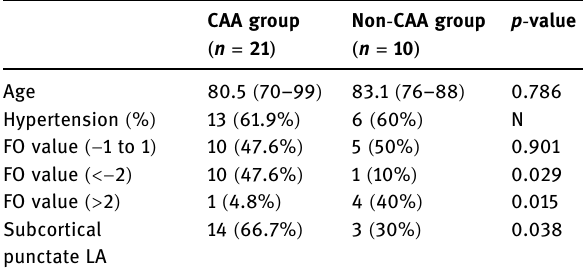
Table 2: Distribution of LA in CAA group and non - CAA